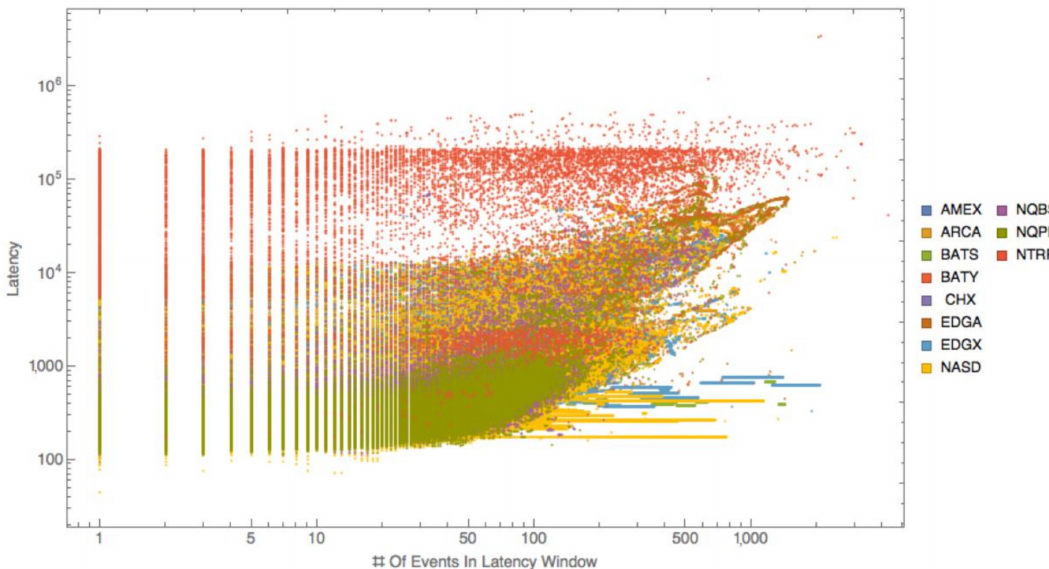
Figure 18. Number of events in latency window for Apple stock on 11 August